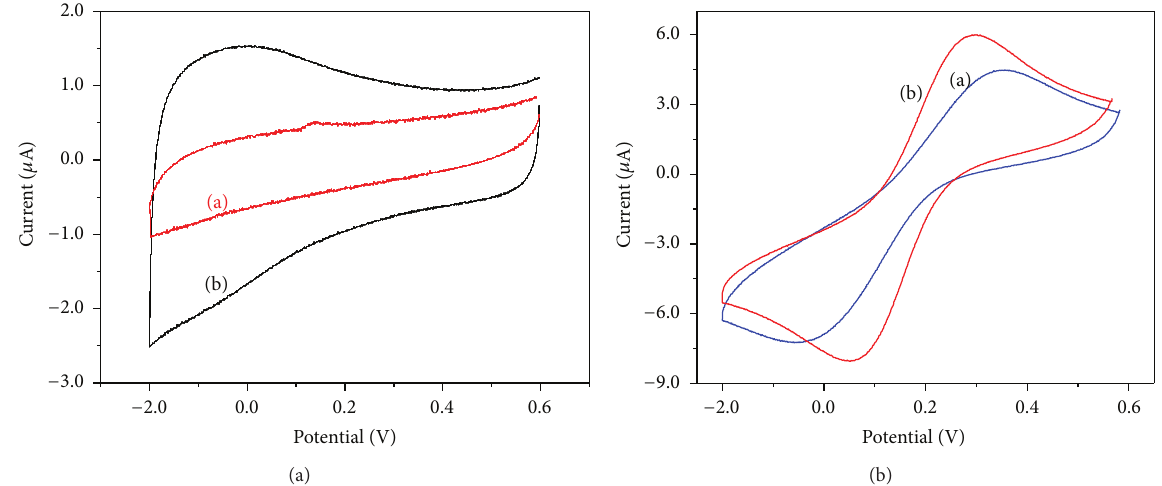
Figure 6: Cyclic voltammograms recorded for (a) bare GC and (b) 𝛼 -Fe 2 O 3 nanoparticle-modified electrode with 0.1M KCl in (a) absence and (b) presence of 1 × 10 −3 M K 3 [Fe(CN) 6 ] at scan rate of 50 mVs −1